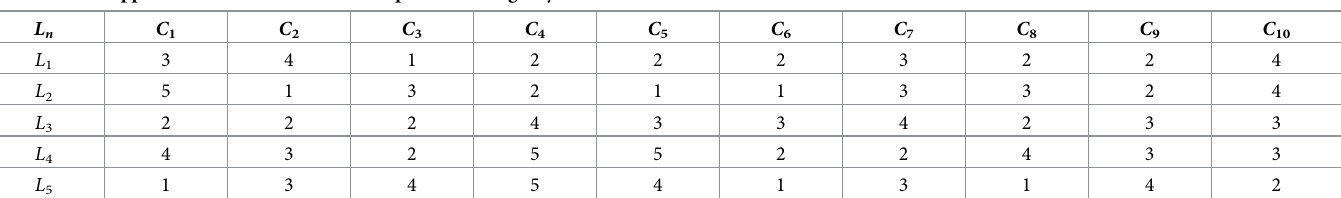
Table 8. The supplier’s evaluation of material requirements urgency.